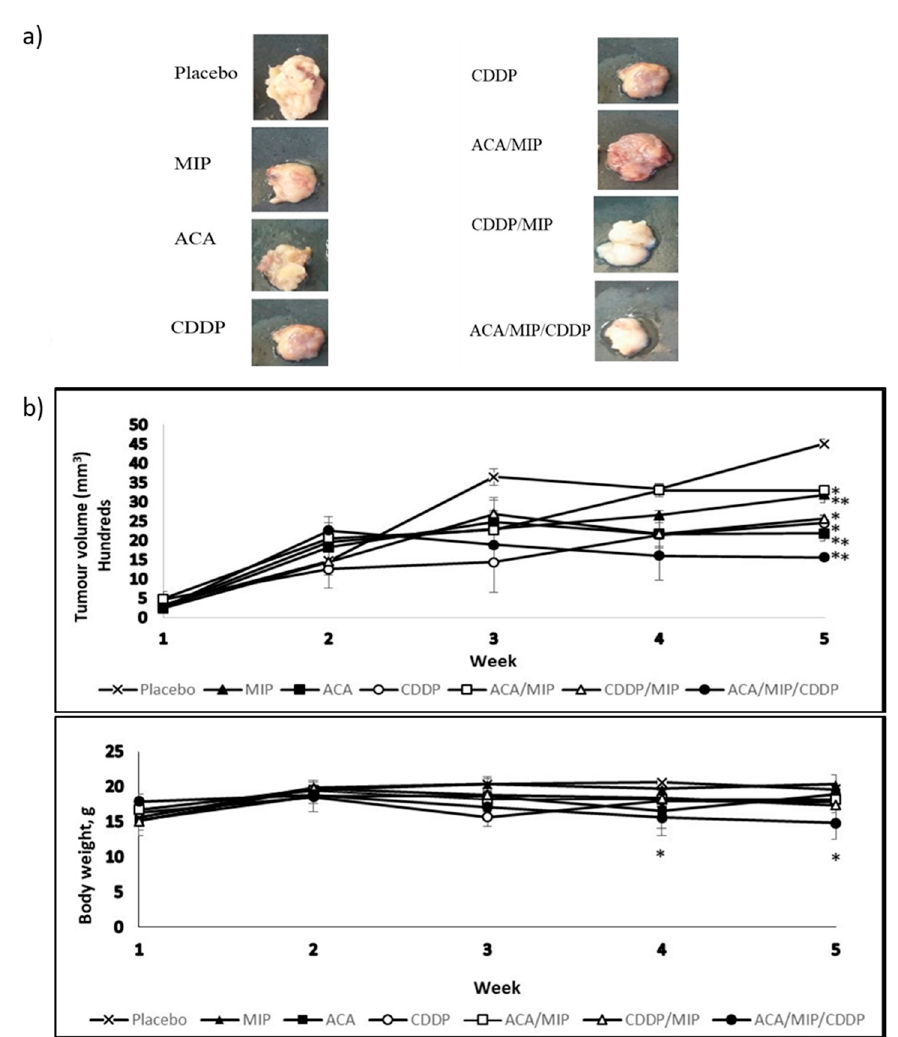
Figure 1. ( a ) Images of tumors isolated from BALB/c mice 35 days post-treatment with a subcutaneous saline injection or with various 1 ′ -S-1 ′ -acetoxychavicol acetate (ACA), Mycobacterium indicus pranii (MIP), and cisplatin (CDDP) treatment regimens. All mice were terminated via euthanasia using a flow of pure carbon dioxide (CO 2 ) in a gas chamber. Dissections were carried out and tumors were measured and fixed in a 10% ( v / v ) neutral buffered formalin (NBF) buffer solution for immunohistochemistry (IHC) analysis. ( b ) Tumor growth and body weight change in 4T1-bearing mice treated with different regimens over a period of five weeks. Tumor volume was calculated from the second week. Data were shown as mean ± standard deviation (SD). Statistically significant changes between the placebo and treatment groups on the fifth week are indicated as * for p < 0.05 and ** for p < 0.01.